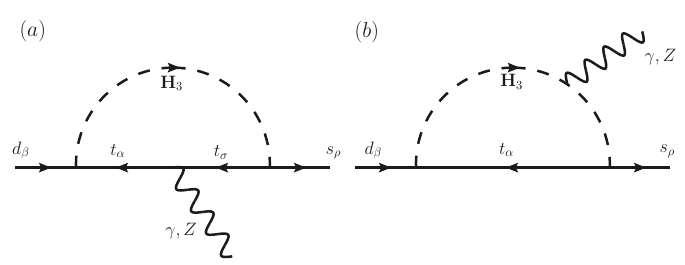
Figure 3 . Feynman diagrams for the d ! s ( (cid:13) (